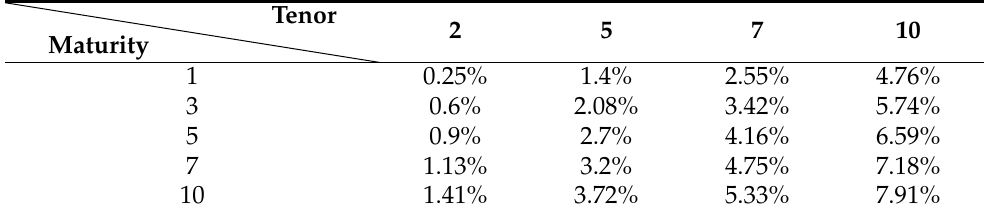
Table A5. Bloomberg’s Hull–White one factor prices of payer Bermudan swaptions on 30 Decem- ber 2019.